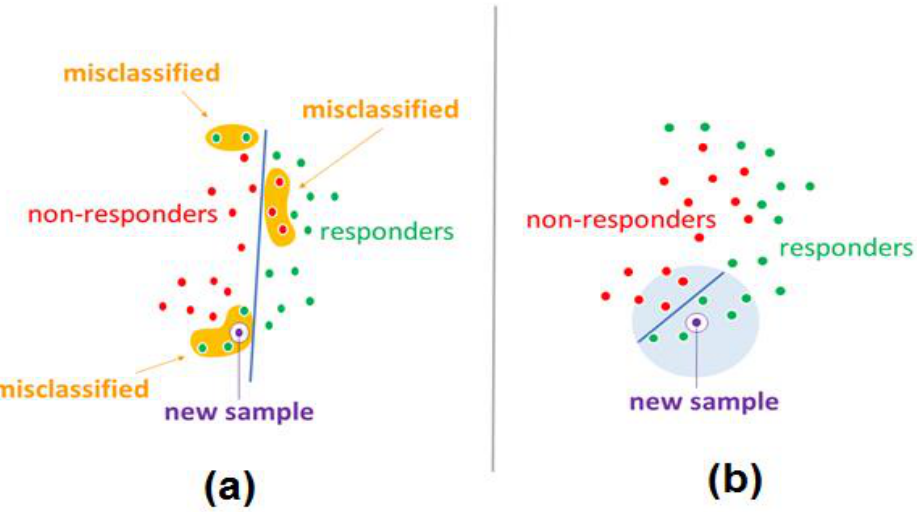
Figure 2. Schematic view of global-local order hybrid ML analytic pipeline (adopted after [8]; copyright belongs to the authors of [8], who wrote also the current paper). ( a ) Global machine learning methods may fail to separate classes for datasets without global order. ( b ) ML, coupled with FloWPS, works locally and handles that cases more accurately.